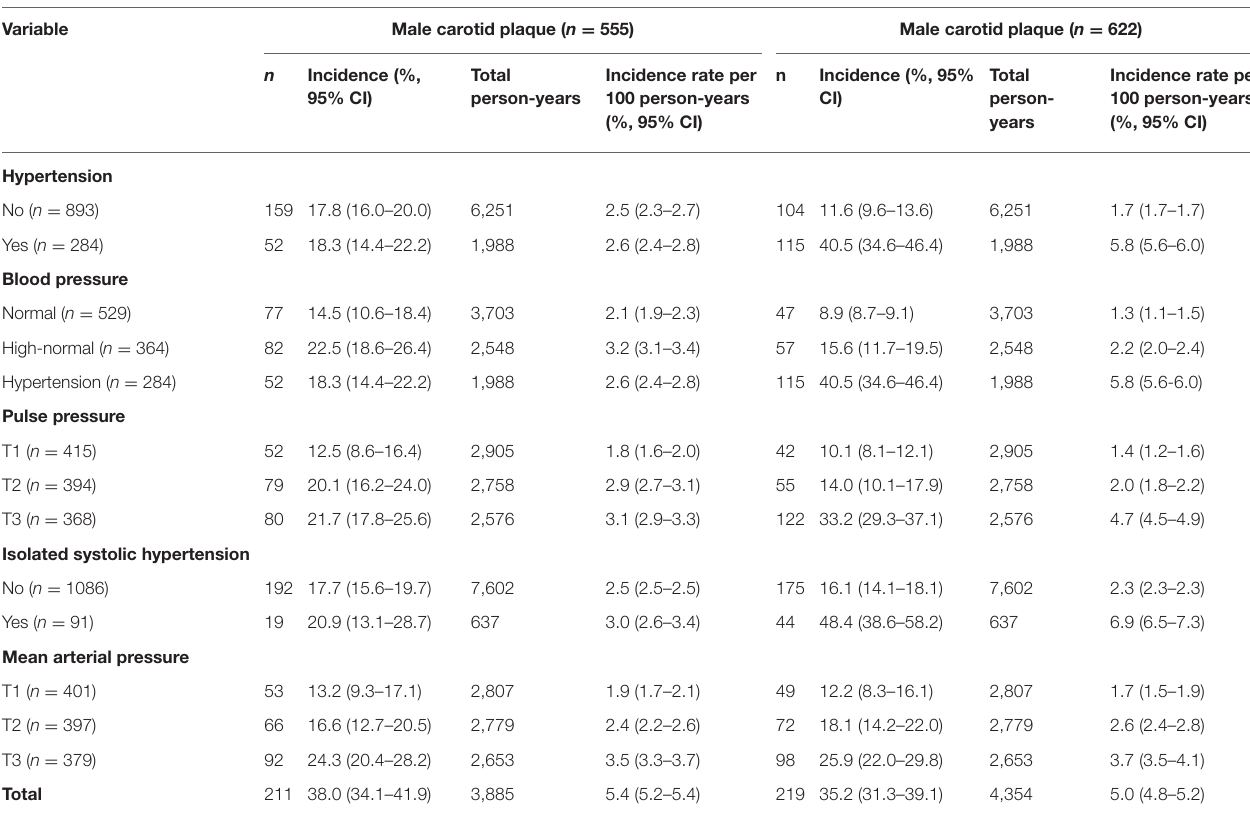
TABLE 2 | Incidence of carotid atherosclerosis at 7-year follow-up in subjects stratified by baseline blood pressure (BP).